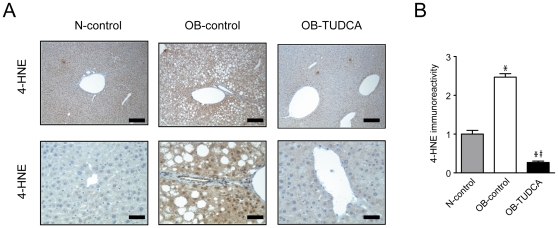
Effects of oral TUDCA treatment on lipid peroxidation.(A) The 4-HNE staining of the liver shows that lipid peroxidation is increased in ob/ob mice, which is reduced by TUDCA treatment. Scale bars in the top and bottom images indicate 200 µm and 800 µm, respectively. (B) Quantification of the intensity of 4-HNE staining. * denotes P<0.05 compared to the N-control, and # denotes P<0.05 compared to OB-control.